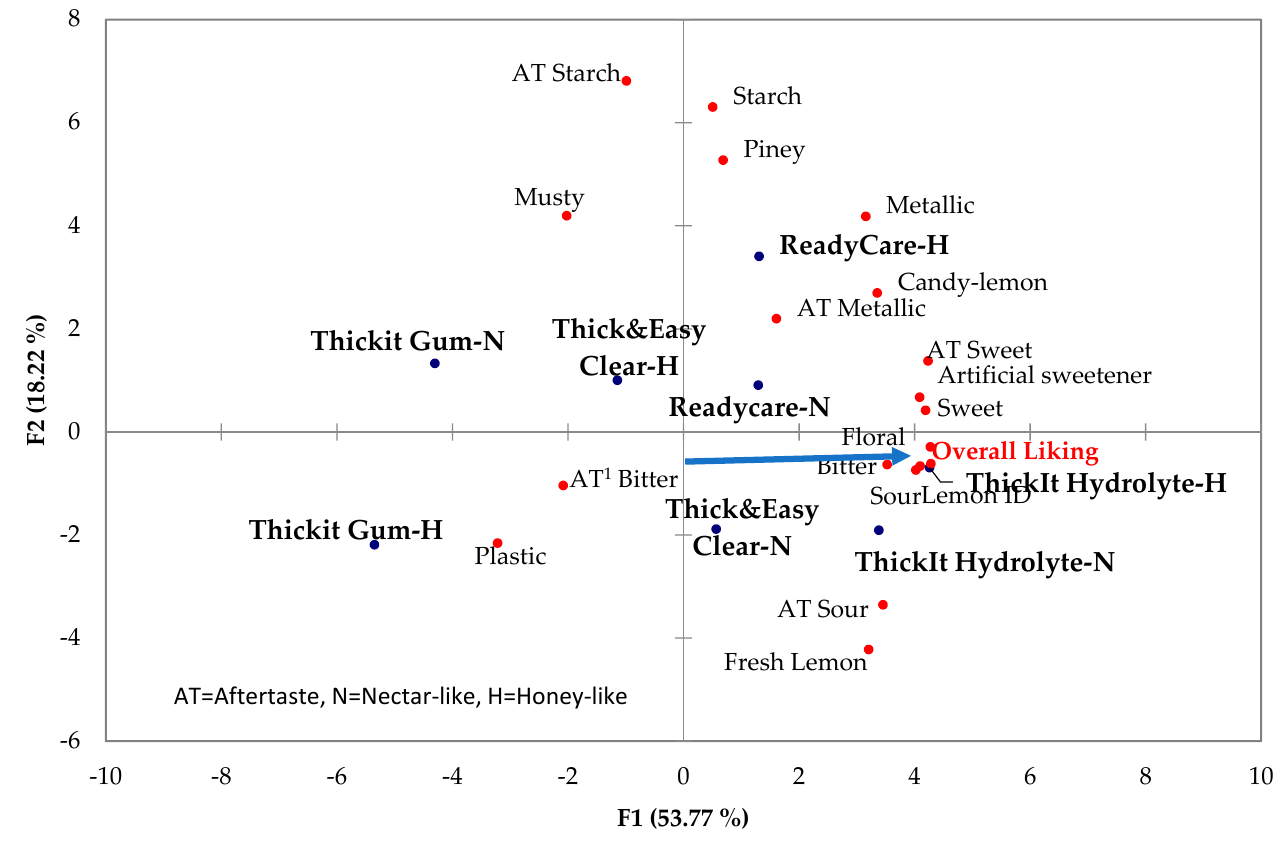
Figure 3. External preference mapping (texture) FC = From Cup.